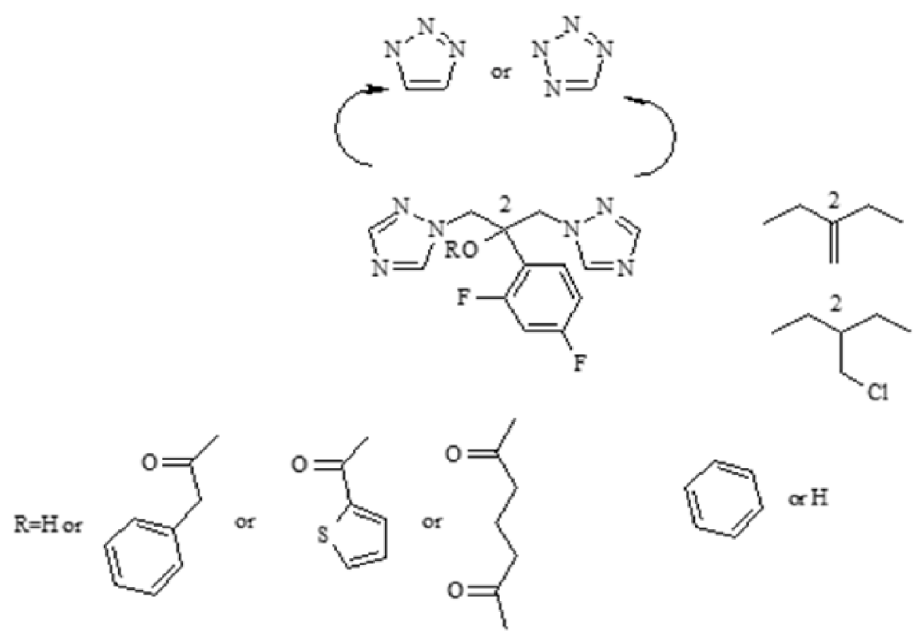
Figure 3. Strategy of design of fluconazole derivatives.